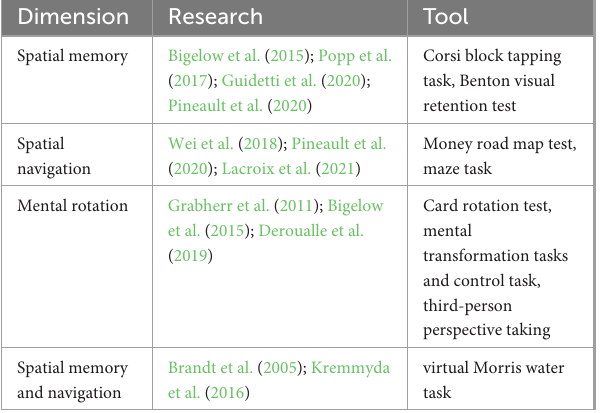
TABLE 1 Application of visuospatial tools in patients with vestibular dysfunction in previous clinical